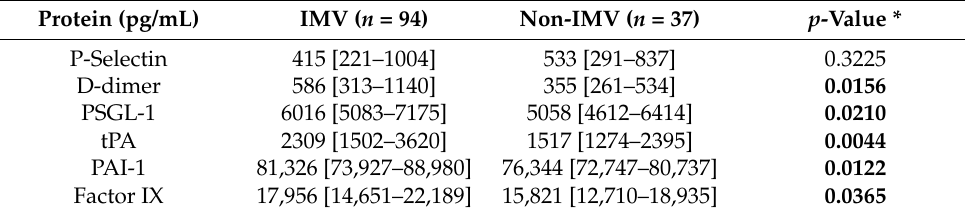
Table 2. Differences in coagulation proteins’ levels according to IMV and Non-IMV groups ( n = 131).